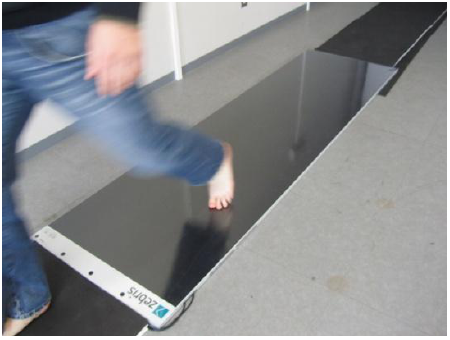
Figure 2. A platform based foot plantar pressure sensor by Zebris Medical GmbH [25].